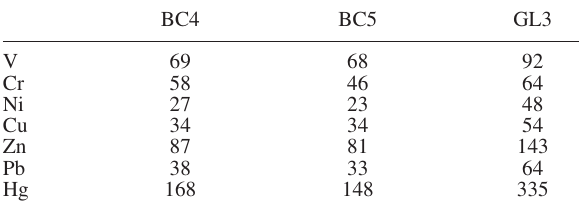
Fig . 2. – Depth profiles of TC, OC, TN, and OC:TN molar ratios of sediment cores from the Gulf of Cádiz. The origin of the cores is shown in Figure 1. Sediment cores BC4 and BC5 were obtained from the outer Bay of Cádiz, whereas core GL3 was obtained from the submarine prodelta of the River Guadalquivir. Table 1. – Concentrations of metals measured in each core. Results for V, Cr, Ni, Cu, Zn and Pb are expressed in μg·g -1 , whereas results for Hg are expressed in ng·g -1 . Sediment cores BC4 and BC5 were obtained from the outer Bay of Cádiz, whereas core GL3 was ob- tained from the submarine prodelta of the River